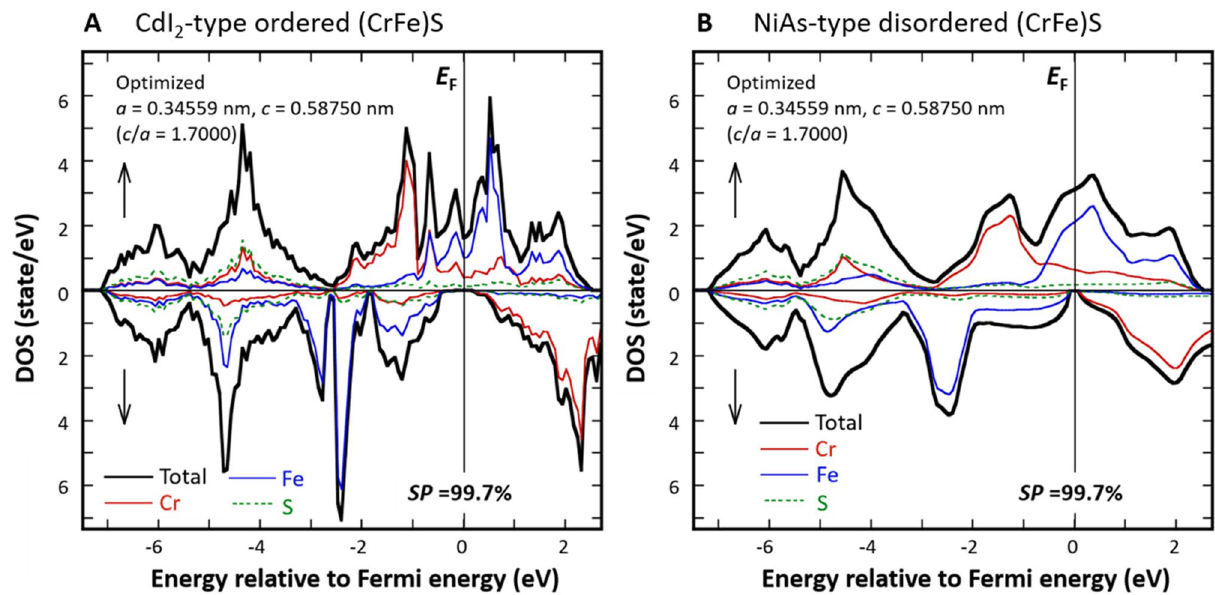
Figure 4. Density of states (DOS). Partial DOS of Cr, Fe, and S and the total DOS of ( A ) CdI 2 -type ordered and ( B ) NiAs-type disordered (CrFe)S with a stoichiometric composition, calculated using the optimised lattice parameters by the KKR method. The coherent potential approximation (CPA) method was used to calculate the disordered state. Partial DOS refers to the angular-momentum-decomposed DOS within the Voronoi cell surrounding each constituent atom. SP : spin